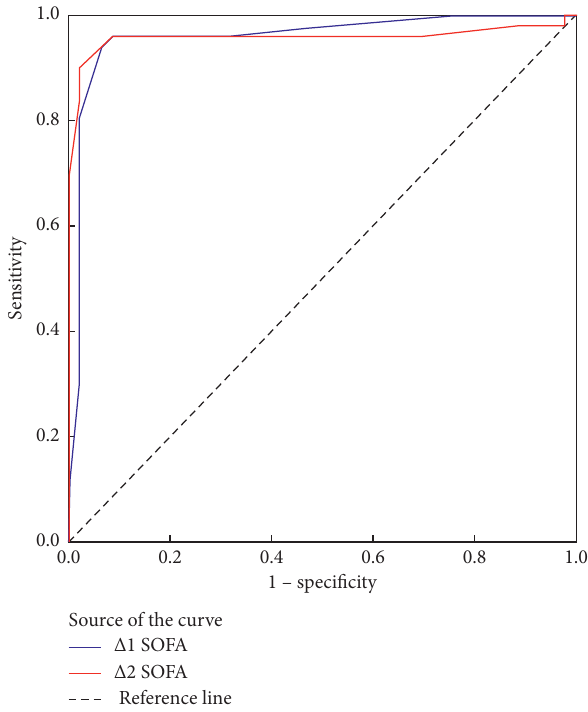
Figure 3: ROC of ∆ 1 SOFA and ∆ 2 SOFA in differentiating mortality.